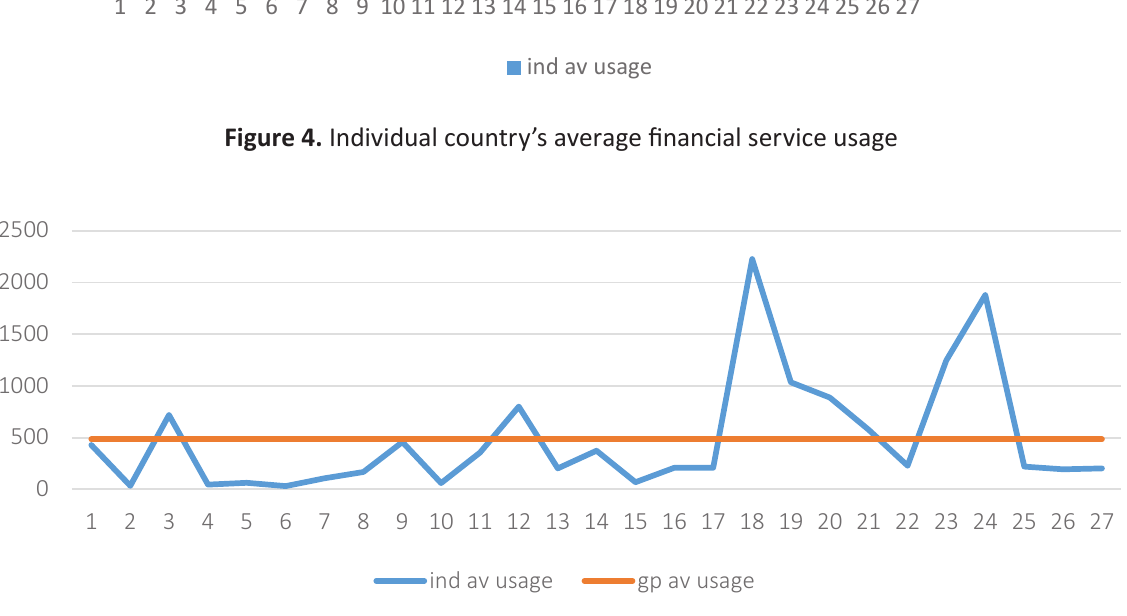
Figure 5. Decomposing countries into high and low usage of financial